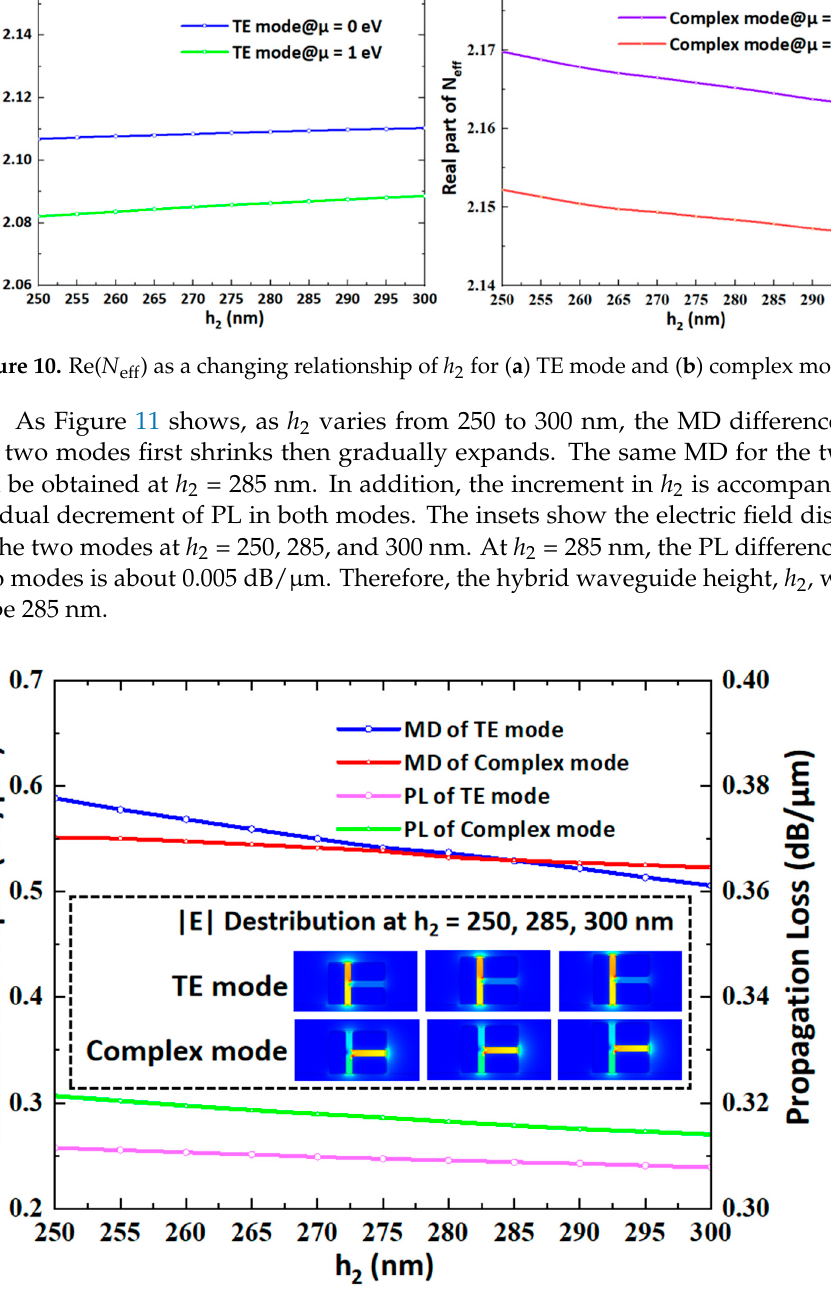
2 for TE mode and complex